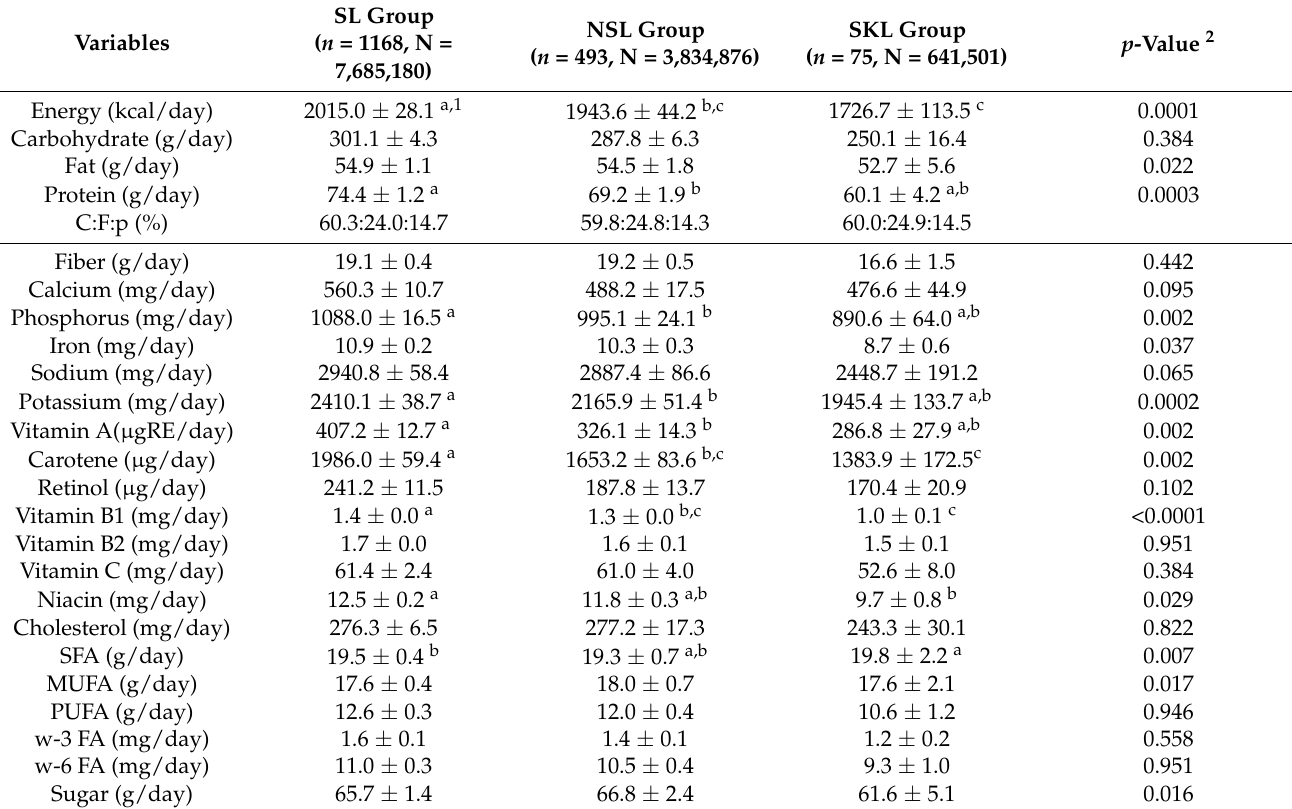
Table 3. Daily nutrients intake according to lunch type among children and adolescents in South